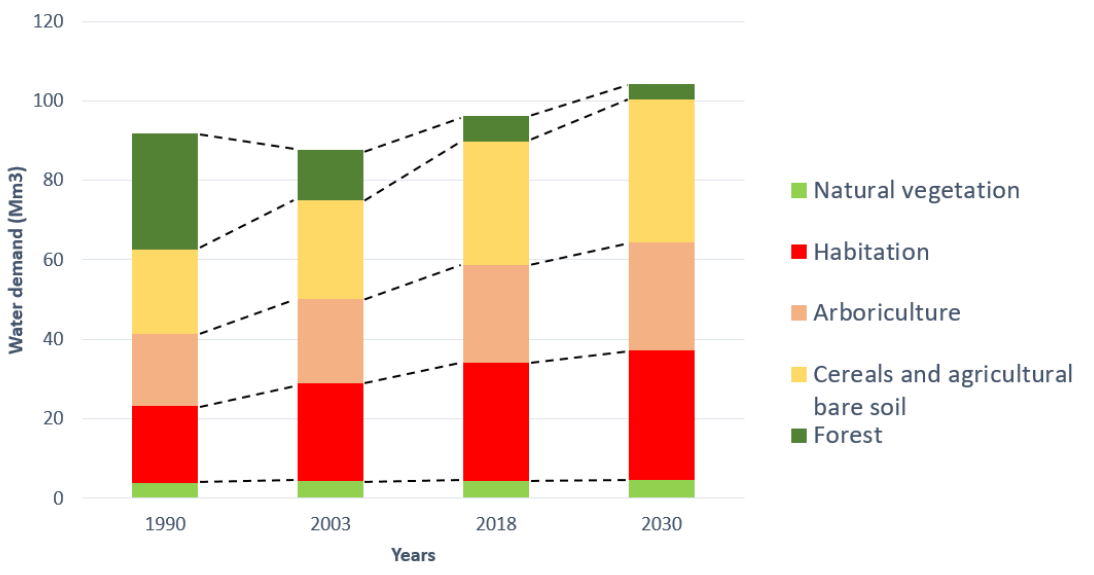
Figure 8. Depth of the water table piezometric surface. 3.5. Results’ Interpretation The combination of satellite image processing techniques, surveys and field data to study the relationship of land use change and its relation to water availability, demand and consumption has been very effective in assessing water balances at the regional scale. In particular, the classification used in this work showed a high degree of accuracy, and clearly described the different changes in the study area during the last 28 years. Furthermore, the combination of satellite and field data allows us to assess the water balances in the Boufakrane river watershed. Throughout the literature analysis, for several works about the same research topic, remote sensing has shown a strong performance in the study of land use/cover changes [14,16], the development and generation of land-use change scenarios for hydrological modeling [53] and urban dynamics [29,54 – 56]. For example, Ashraf M. Dewan et al. [29] studied land-use changes in Greater Dhaka, Bangladesh for a period of 28 years, based on remote sensing images to promote sustainable urbanization. They found that the Dhaka region had experienced rapid changes in land use, particularly in the urban area. In a related context, A. El Garouani et al. [57] carried out a study to understand the relationship between urbanization and land use/land cover changes and their impacts on the urban landscape